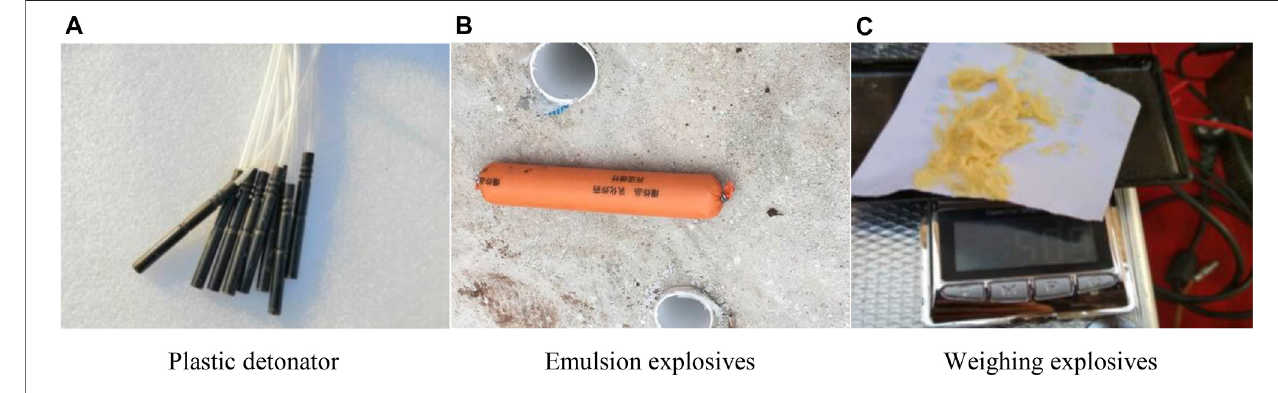
FIGURE 3 | Materials for blasting physical simulation test.